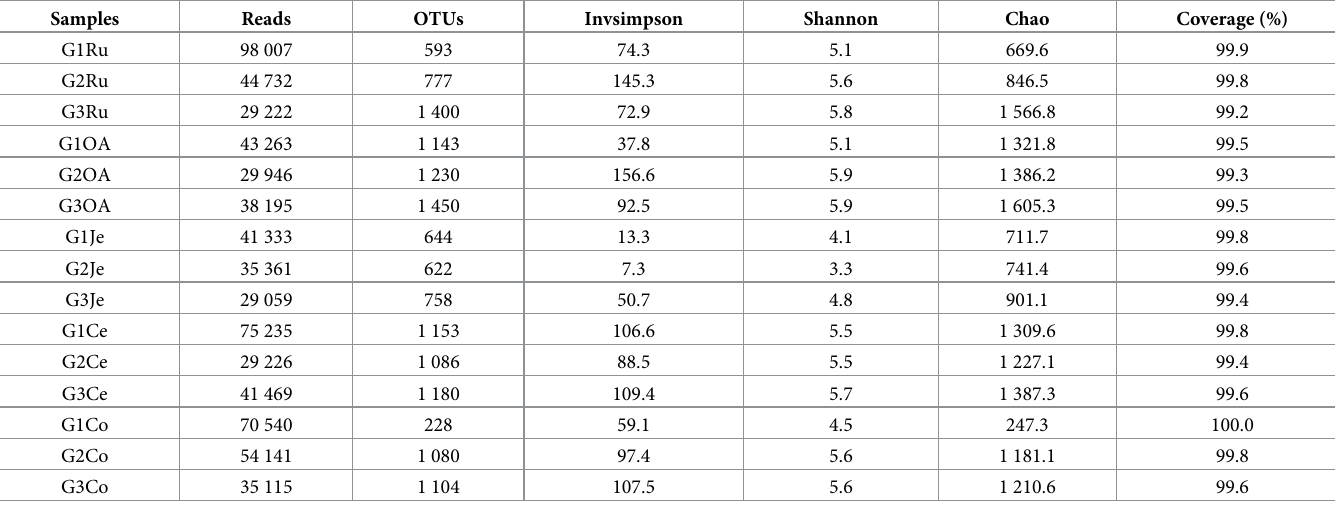
Table 1. 16S rRNA gene sequences, richness and alpha-diversity estimates of Bacteria at the GIT of three goats.